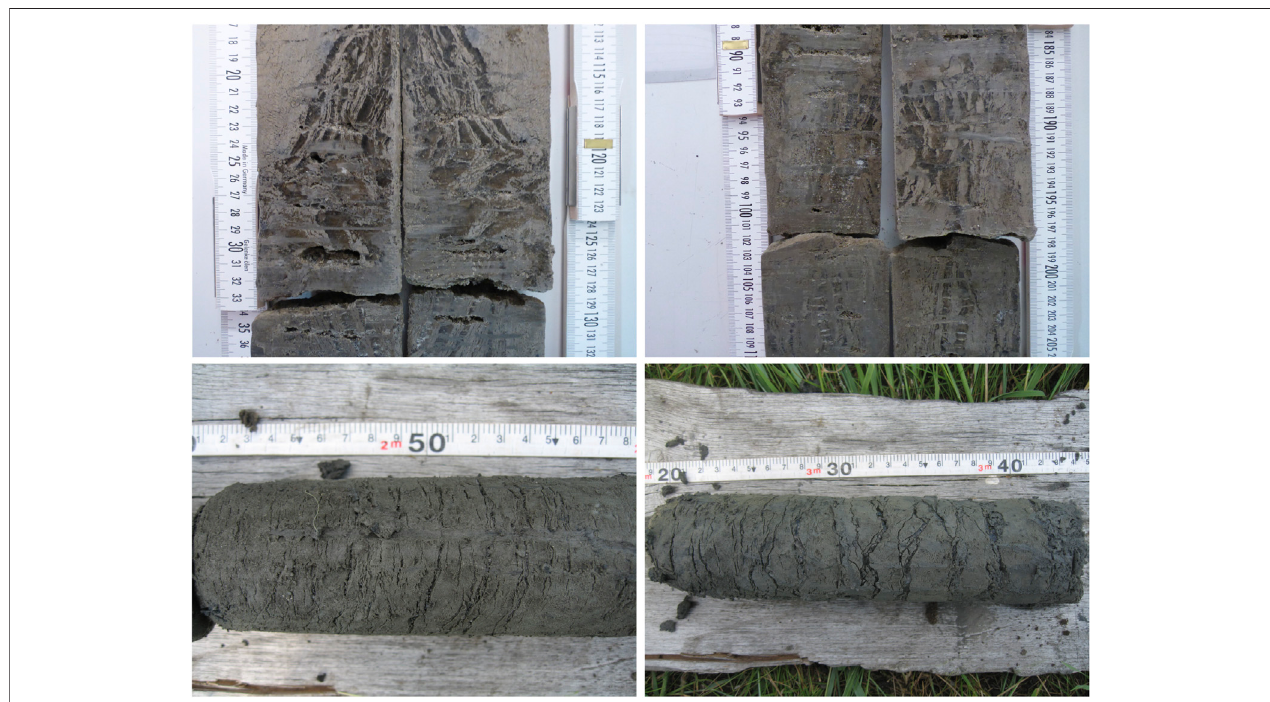
FIGURE 10 | Comparison of different cryostructures within the study region of Central Yakutia. (Above) Cryostructures of Y-SU-I at about 2,200 cm bls of the YedomalakecoreYU-L15(thisstudy)incomparisonto (Below) cryostructuresthathaveformedbythedownwardmoisturemigrationinsubaquaticdepositsduringtalik re-freezing from the nearby alas basin Khara Bulgunnyakh (Ulrich et al., 2017a).